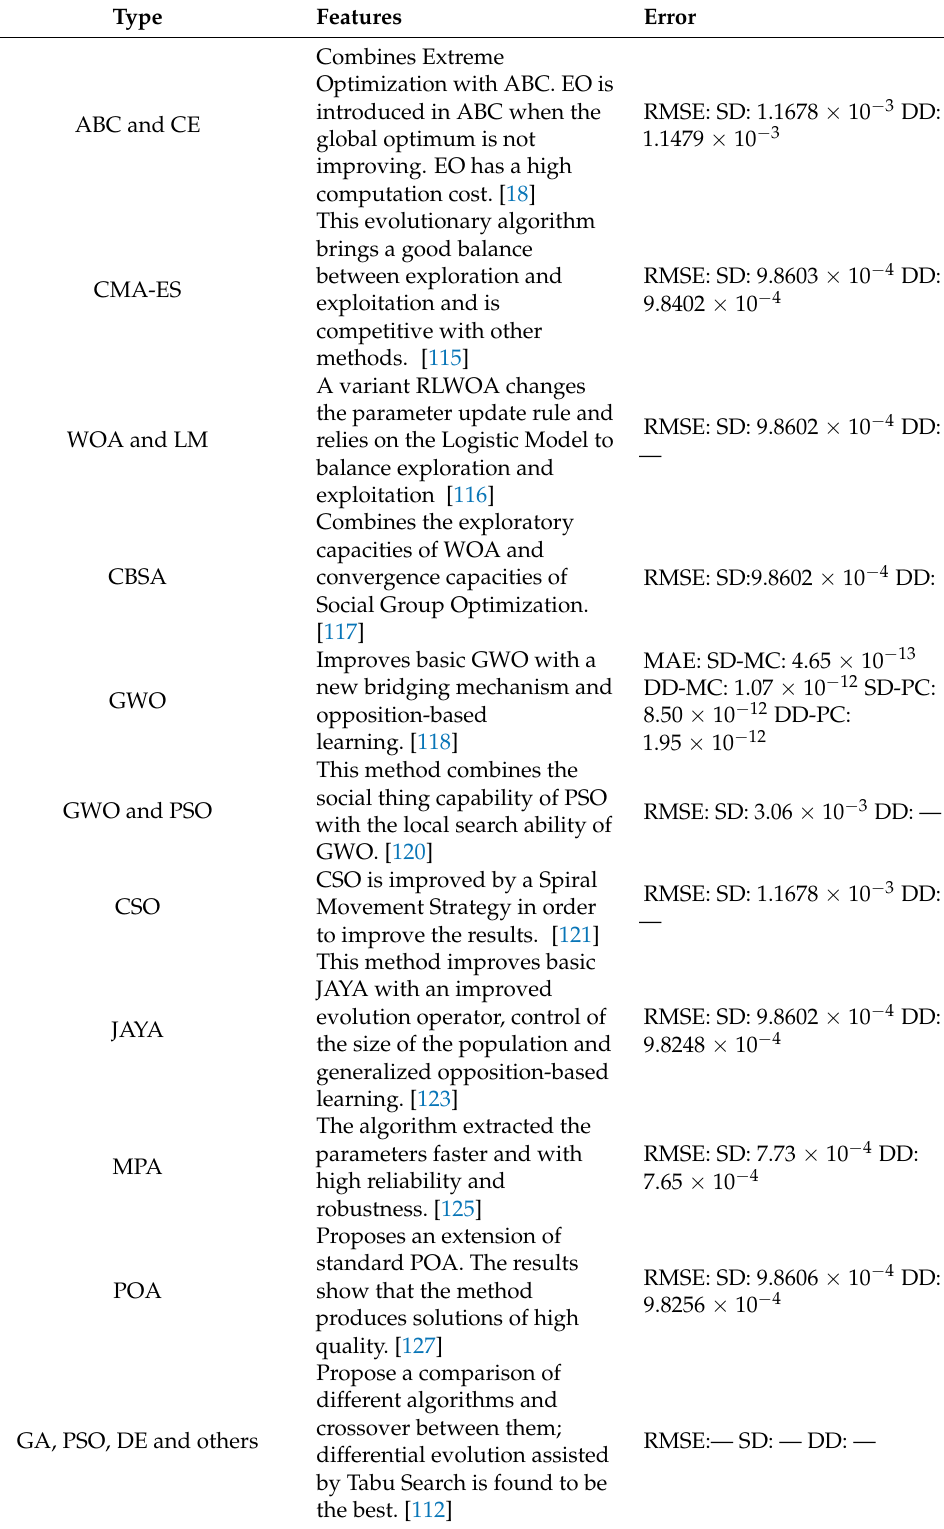
Table 6. Models for parameter estimation. SD: single diode, DD: double diode, MC: monocrystalline, PC: